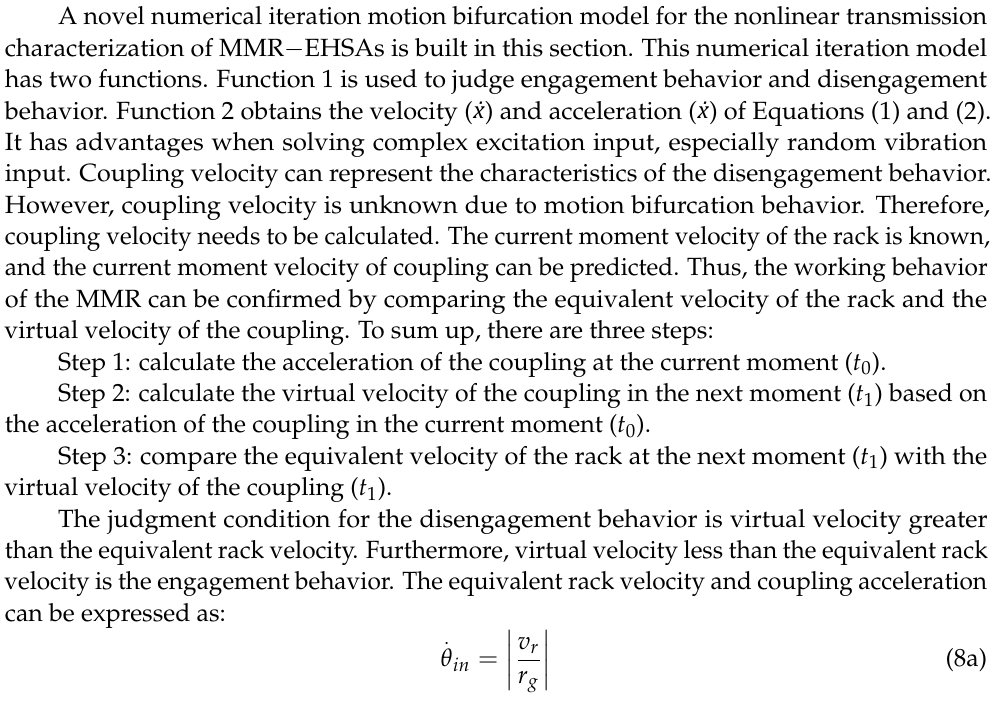
Figure 3. Proposed mechanical models for the MMR − EHSA. ( a ) Engagement model. ( b ) Disengage- ment model.